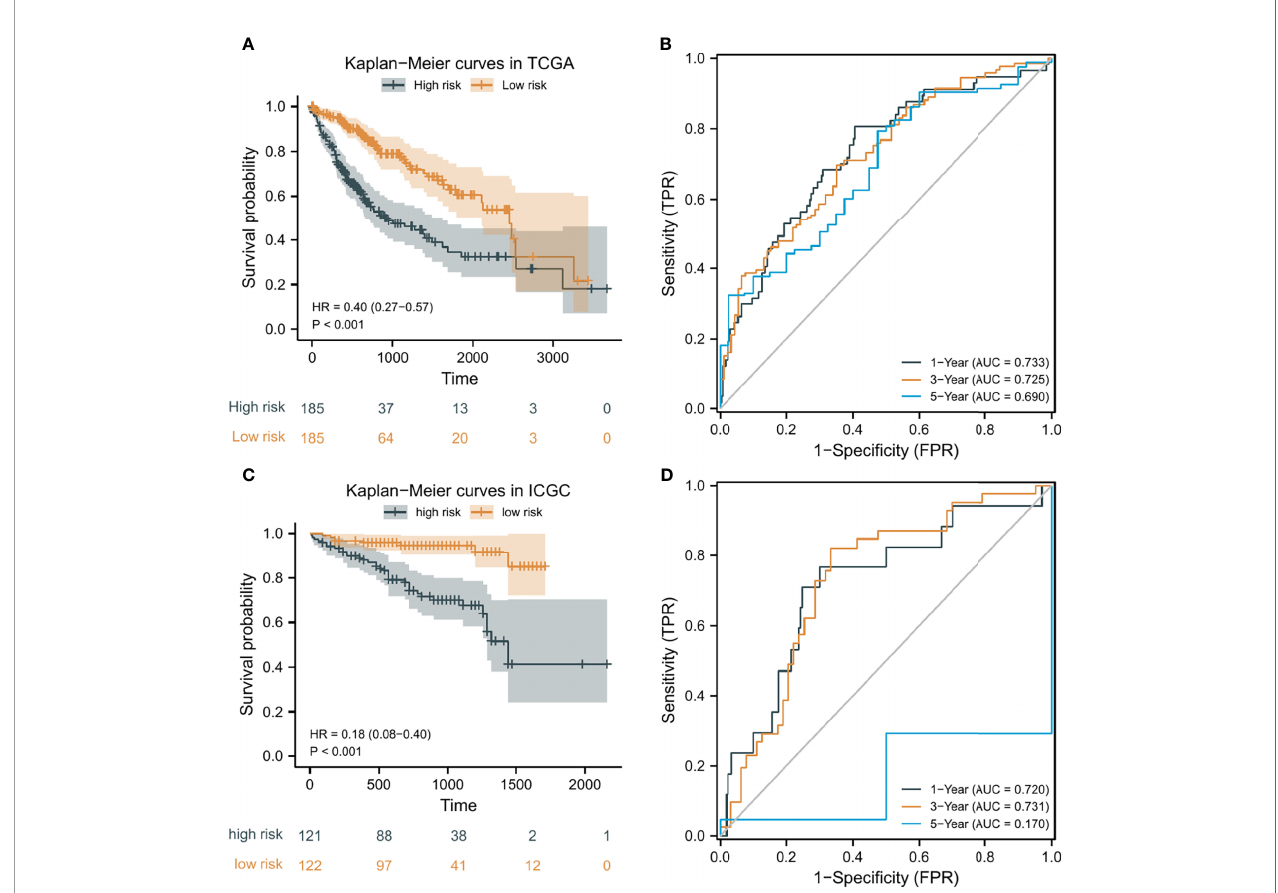
FIGURE 4 | Kaplan-Meier (K-M) curves and time-dependent receiver operating characteristic (ROC) curves of the prognostic model of HCC patients. (A, C) K-M curves of the prognostic model in TCGA and ICGC, respectively. (B, D) 1-year, 3-year, and 5-year ROC curves of the prognostic model in TCGA and ICGC,